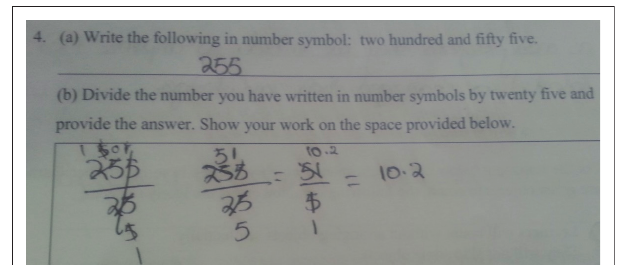
FIGURE 4: Response of Teacher 4.